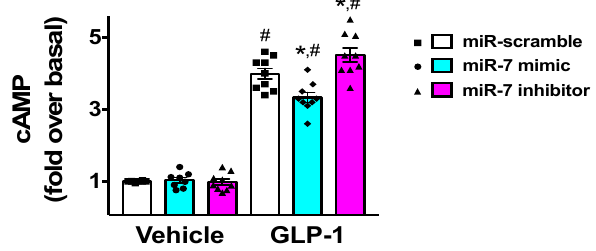
Figure 4. Effects of miR-7 on GLP-1-mediated cAMP production. INS-1 cells treated with miR-7 mimic, inhibitor, or scramble (negative control) were stimulated for 2 h with GLP-1 (100 nM) or vehicle and cAMP was measured. Means ± S.E.M. are shown alongside actual values. Basal, vehicle + miR-scramble; * p < 0.05 vs. miR-scramble, # p < 0.05 vs. vehicle.